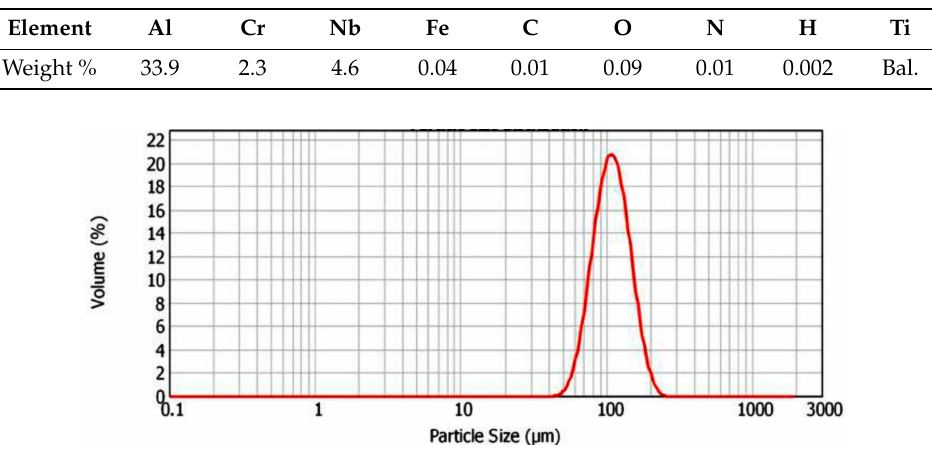
Figure 1. Powder particle size distribution measured by laser diffraction technique.